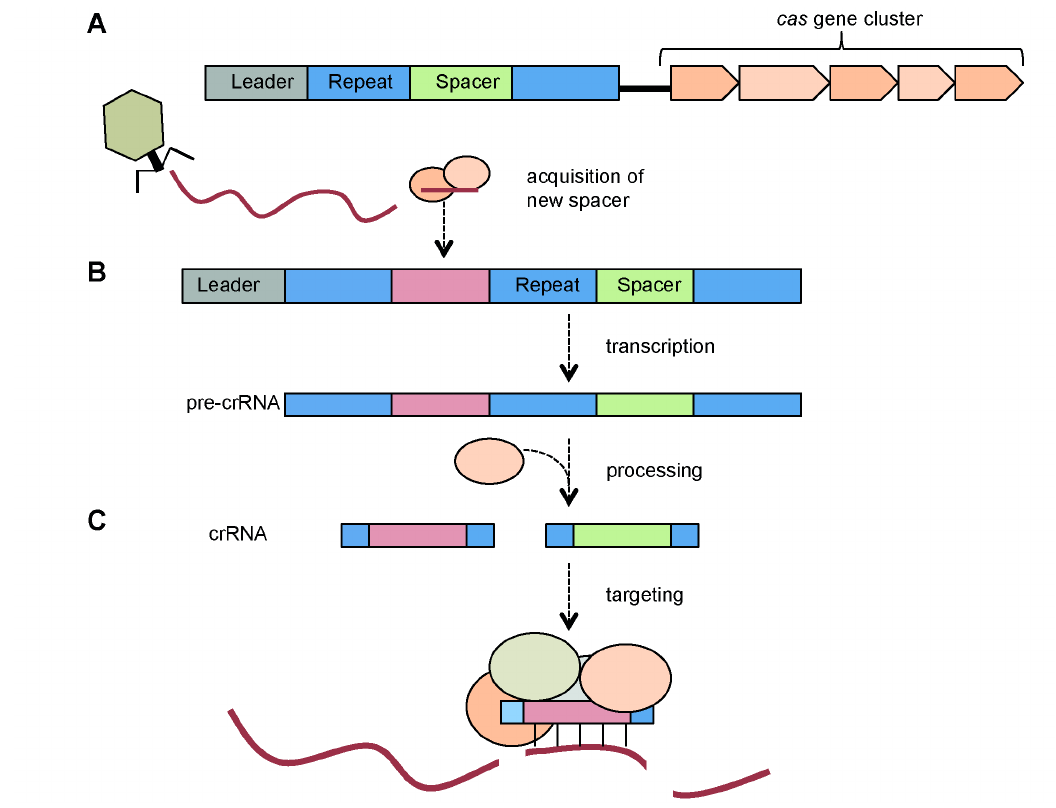
Figure 1. Overview of c lustered r egularly i nterspaced s hort p alindromic r epeats ( CRISPR)/C RISPR as sociated ( Cas) adaptive immunity. ( a ) Adaptation. The CRISPR arrays are composed of short repeats and intervening sequences derived from foreign invaders. Upon infection with a foreign element (e.g., phages or plasmids), part of the genome is typically incorporated into the leader end of the CRISPR array and the repeat is duplicated. The CRISPR arrays are located adjacent to a cluster of cas genes; ( b ) crRNA generation. The CRISPRs are transcribed into pre-crRNAs that are then processed into mature crRNAs; ( c ) Interference. The crRNA, in a complex with Cas proteins, binds and degrades the target nucleic acid of the invading